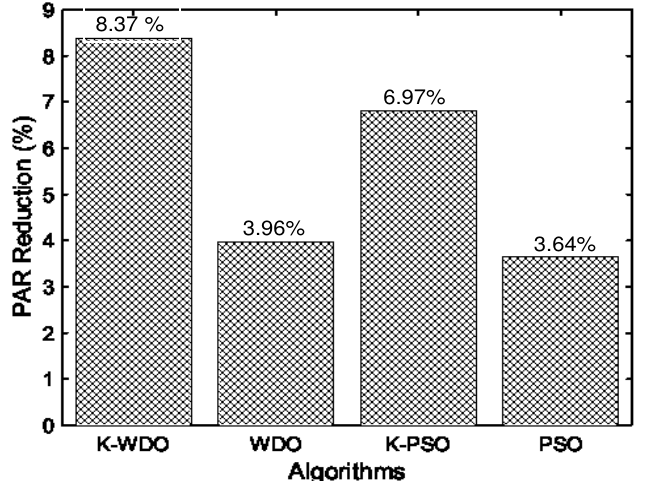
Figure 12. Total peak-to-average ratio (PAR) reduction comparison of the WDO and PSO algorithms for a simple household based on the TOU price signals adopted from NYISO.